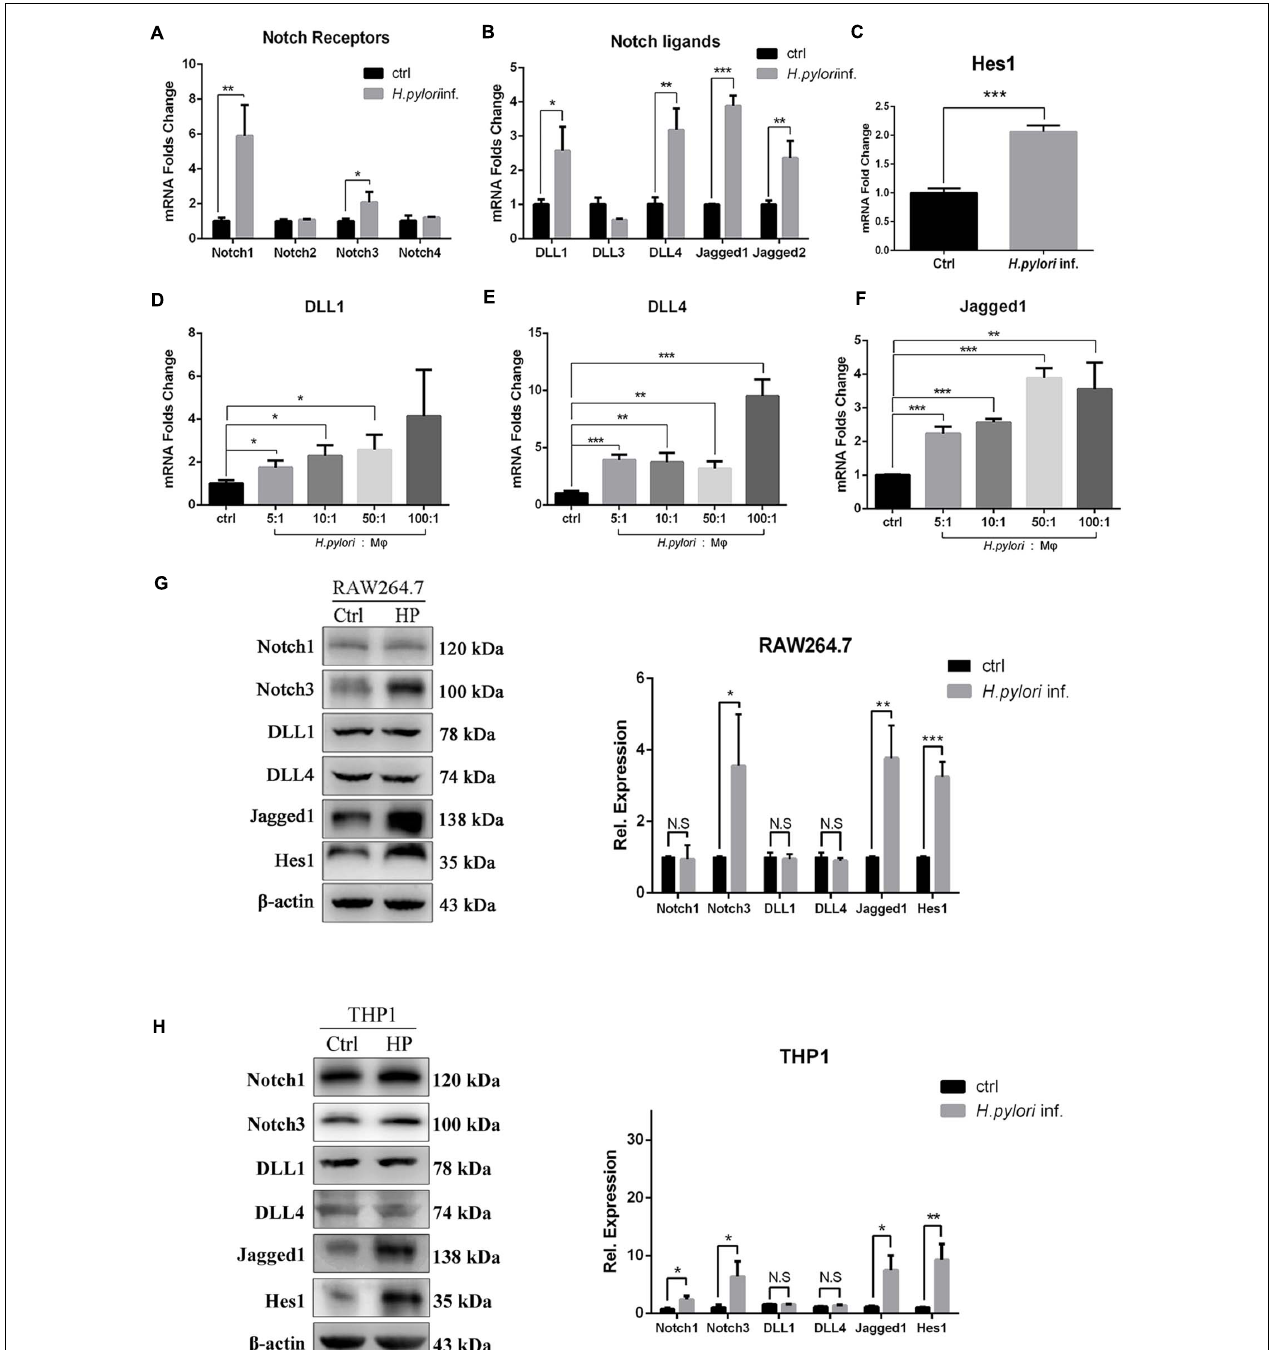
FIGURE 3 | Jagged1 mRNA and protein expression levels are upregulated in H. pylori -activated macrophages. RAW264.7 cells were co-cultured with H. pylori (MOI = 50) for 12 h. PBS was used as control for H. pylori inf. (A–C) qPCR was performed to assess the mRNA expression of Notch receptors, Notch ligands, and Notch target gene Hes1 in RAW264.7 cells. PBS was used as control for H. pylori infection. (D–F) RAW264.7 cells were co-cultured with H. pylori using different MOIs (5, 10, 50, and 100) for 12 h. qPCR was performed to examine the mRNA expression of DLL1, DLL4, and Jagged1 in RAW264.7 cells. Macrophages were co-cultured with H. pylori (MOI = 50) for 12 h, PBS was used as control for H. pylori inf. (G) Western blot was performed to assess the protein expression levels of Notch1, Notch3, DLL1, DLL4, Jagged1, and Hes1 in RAW264.7 cells. The expression bands were analyzed using Gel-pro Software, and the integral optical density (IOD) was obtained. The IOD of β -actin was used as reference. (H) Western blot was performed to assess the protein expression of Notch1, Notch3, DLL1, DLL4, Jagged1, and Hes1 in THP1. Ctrl: uninfected group; H. pylori inf.: H. pylori -infected group. β -actin was used as reference. The data are presented as the mean ± SD of three independent experiments. * p < 0.05, ** p < 0.01 and *** p < 0.001.